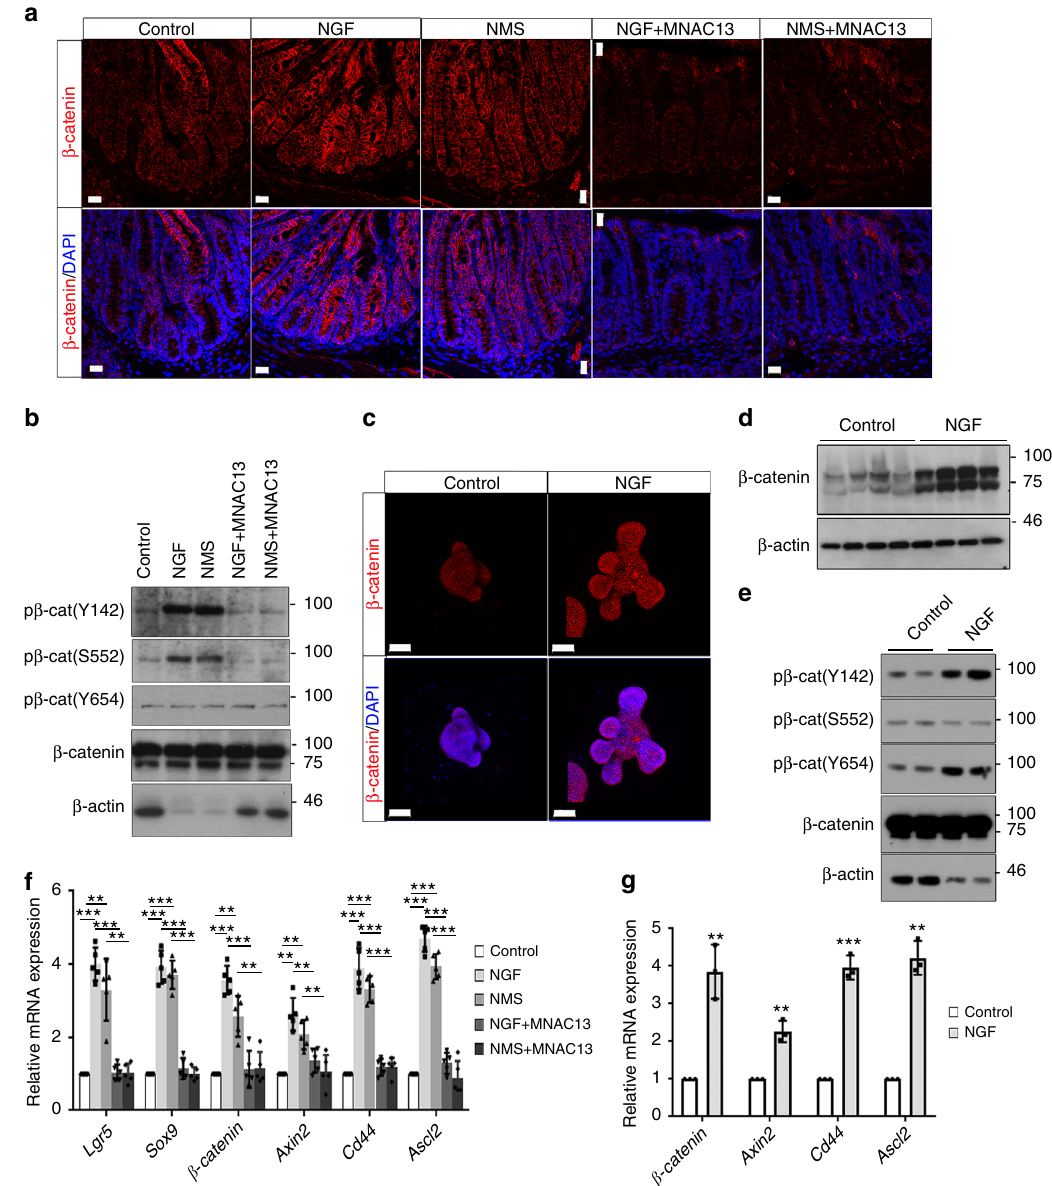
Fig. 4 Exogenous NGF ampli fi es Wnt signaling in intestinal stem cells. a Immuno fl uorescent staining for β -catenin (red) in the sections of proximal colons from control and NMS mice treated with or without intraperitoneal injection of NGF and MNAC13 (scale bars: 20 μ m). b Western blotting analyses on the expression of p- β -catenin (Y142/S552/Y654) in the tissue lysates obtained from a . The protein loading for total β -catenin was normalized and served as a loading control. c Whole-mount co-staining for β -catenin (red) and DAPI (blue) in organoids cultured with/without NGF (scale bars: 50 μ m). d Western blotting analyses for the expression of β -catenin in organoids with/without NGF. β -actin served as a loading control. e The level of p- β -catenin (Y142/S552/Y654) in organoids cultured with/without NGF was analyzed by western blotting. The protein loading for total β -catenin was normalized and served as a loading control. f qPCR analyses on the expression of multiple Wnt-target genes, including Lgr5 , Sox9 , β -catenin , Axin2 , Cd44 , and Ascl2 in Lgr5 EGFP + cells isolated from control and NMS mice treated with or without intraperitoneal injection of NGF and MNAC13 (** p < 0.01; *** p < 0.001, n ≥ 5/group; ANOVA). g qPCR analyses for Wnt-responsive genes, including β -catenin , Axin2 , Cd44 , and Ascl2 in organoids cultured with/without NGF (** p < 0.01; *** p < 0.001, n = 3; two-tailed t test). All data represent the mean ±